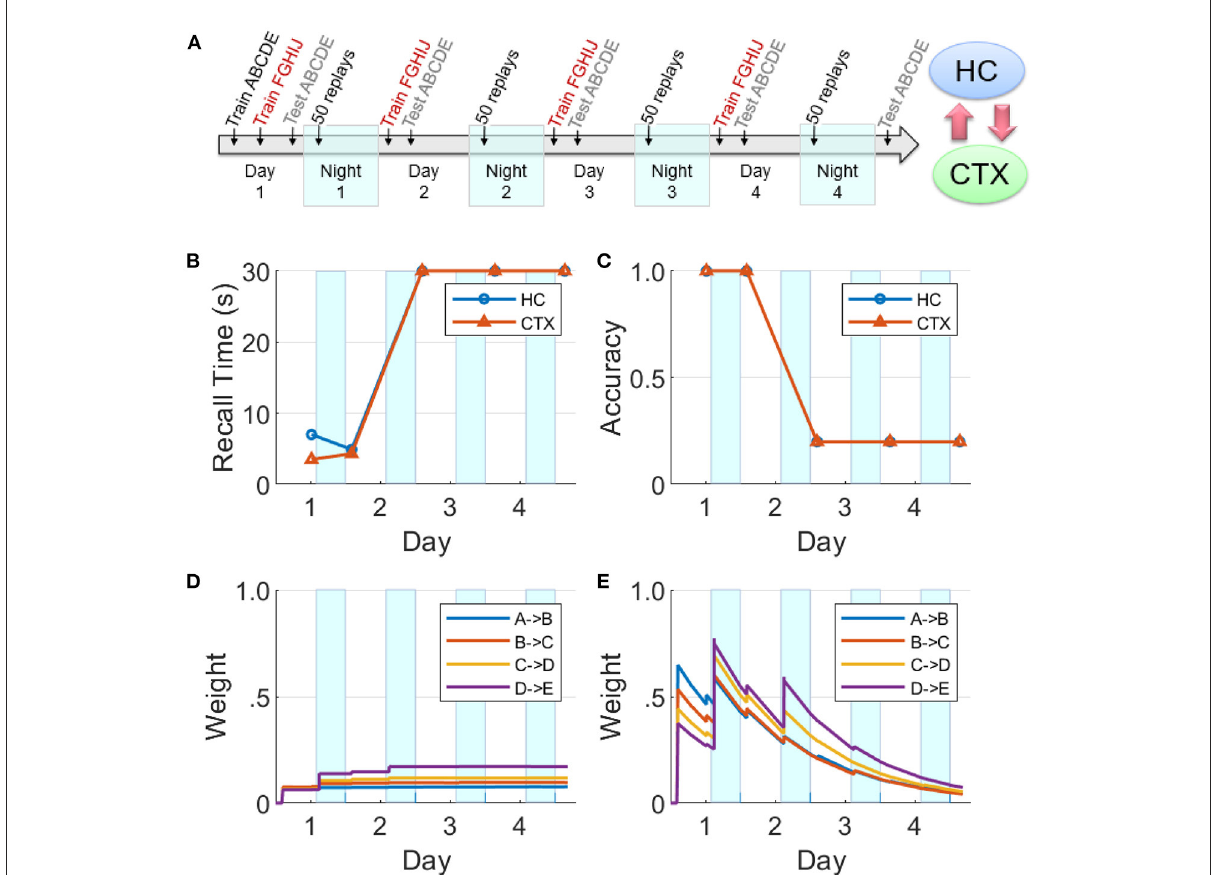
FIGURE10 Effects of competition for limited replay opportunities on memory recall. (A) This experiment is similar to Figure 8, but competition from the more practiced sequence FGHIJ reduces and then eliminates replays of the sequence ABCDE (HC, hippocampus; CTX, cortex). There is a growth of cortical connections in Night 1, but very little in Night 2 and beyond. (B) Recall time for the sequence ABCDE, where 30 s is default for incomplete recalls. (C) Recall accuracy for the sequence ABCDE. (D) Weight strengths in CTX for the sequence ABCDE. (E) Weight strengths in HC for the sequence